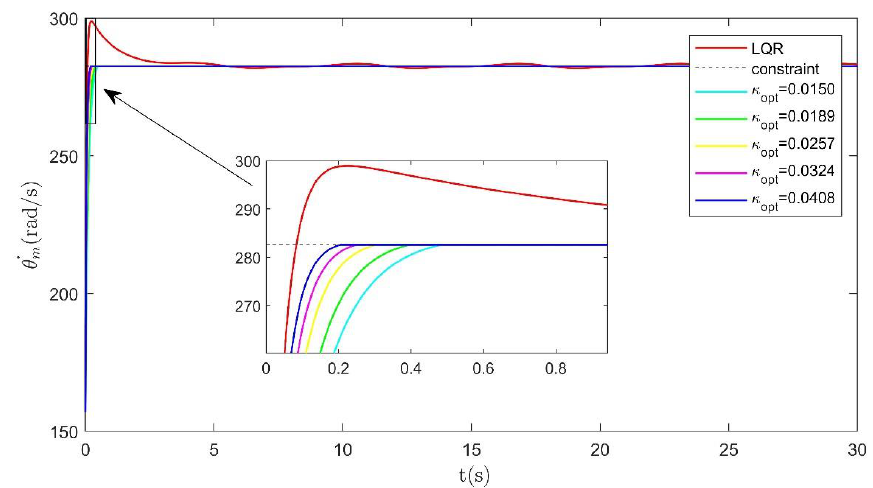
Figure 4. The step tracking speed curve of the electric tail reduction system.